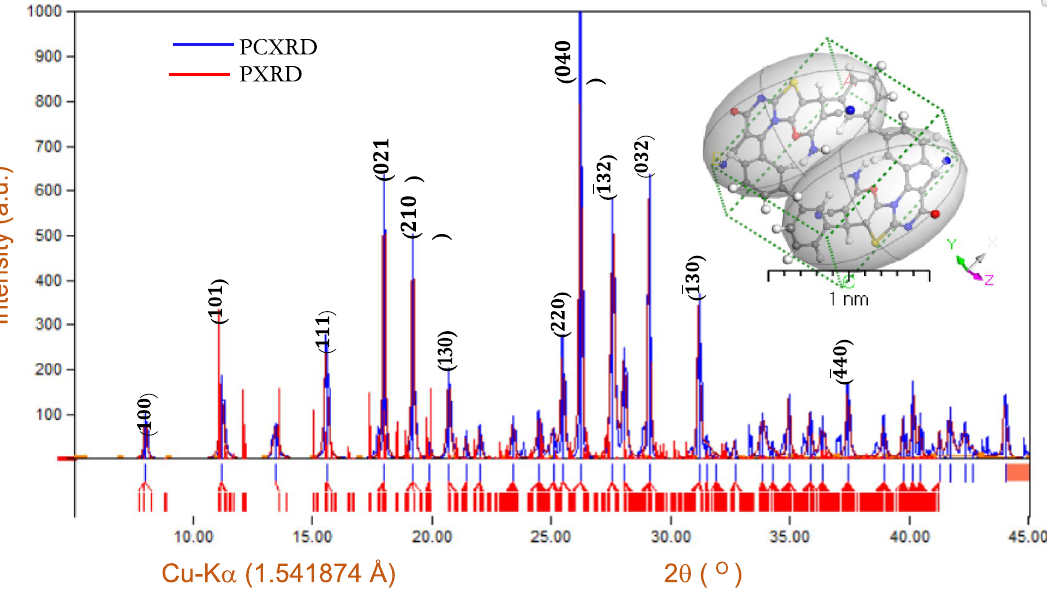
Figure 3. Comparison between the experimental (PXRD) and simulated XRD patterns (PCXRD), inset is a 3D triclinic lattice-type using Polymorph computation method.